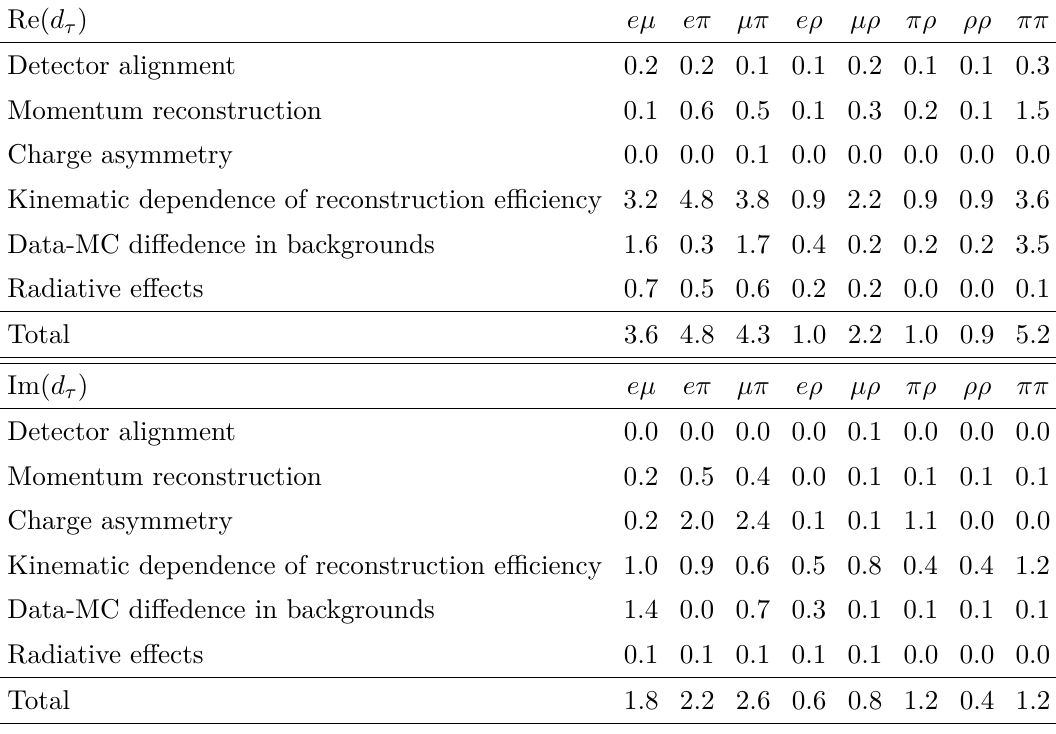
Table 2 . Systematic uncertainties for Re( d τ ) and Im( d τ ) in units of 10 − 17 e cm .